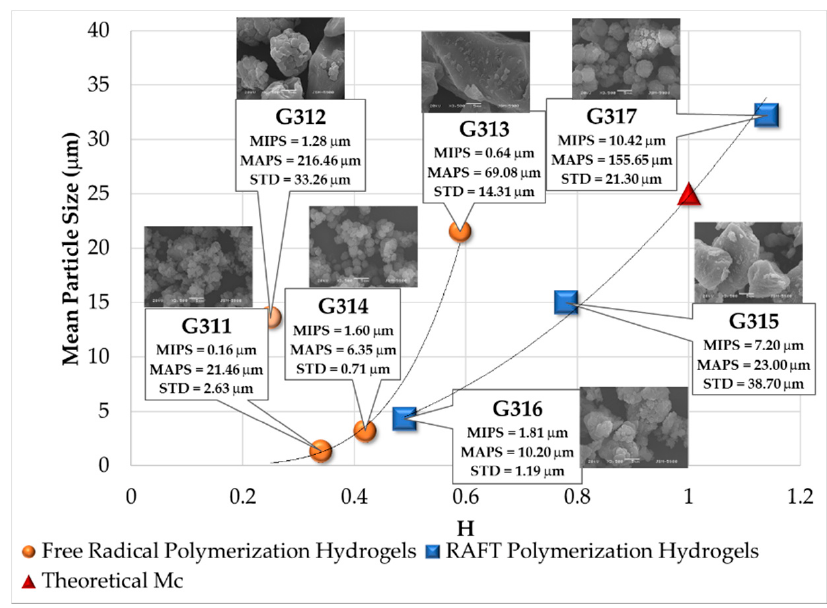
Figure 13. Correlation between MPS and H for hydrogels synthesized by FRP and RAFT copolymerizations of HEMA and EGDMA in scCO 2 . Abbreviations: MIPS = minimum particle size; MAPS = maximum particle size; STD = standard deviation.